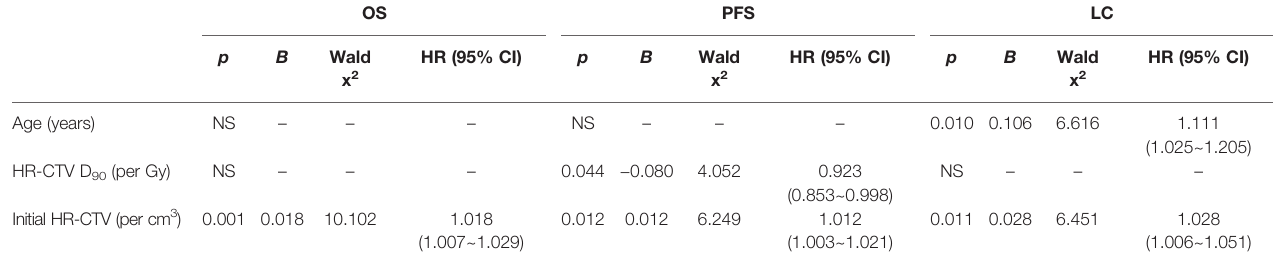
TABLE 5 | Multivariable analyses.